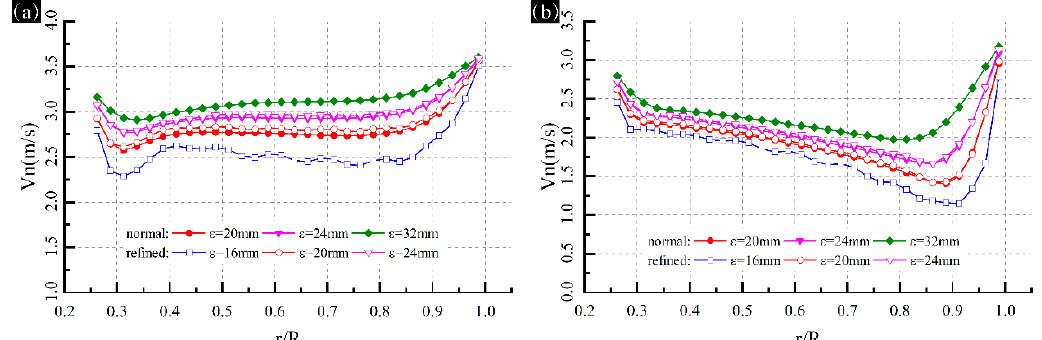
Figure 9. The normal velocity along the blade calculated by two levels of meshes with different Gaussian width when rotating speed is ( a ) 400 RPM, ( b ) 550 RPM. Curves with the same color represent results using the same Gaussian width but different level of mesh.